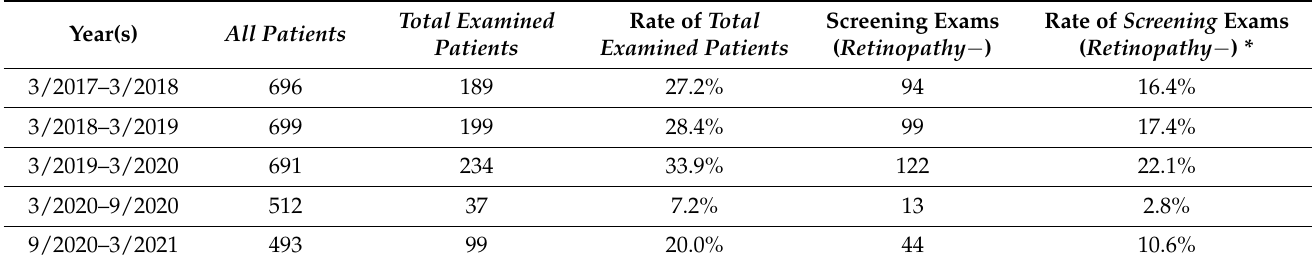
Table 2. Rates of Total Examined Patients and Screening Exams ( Retinopathy − ).